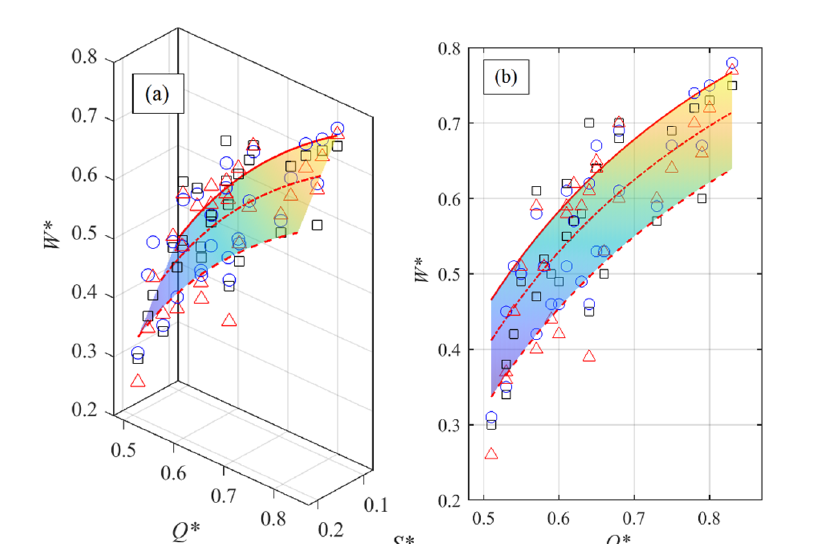
Figure 5. Dimensionless weight W* expressed as a function of the dimensionless water discharge Q* and side weir size S* in comparison with the surface computed with Equation (11) and the contour lines with the same S* : 3D scatter plot ( a ); Q* - W* scatter plot ( b